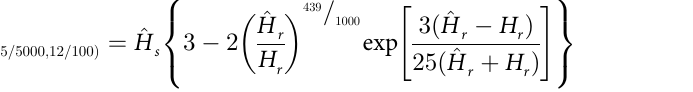
Table 2. Bias and MSE values of members of the proposed class of estimators for population 1. Estimators Bias Variance or MSE ^ M ^ 0.00 565305.20 y